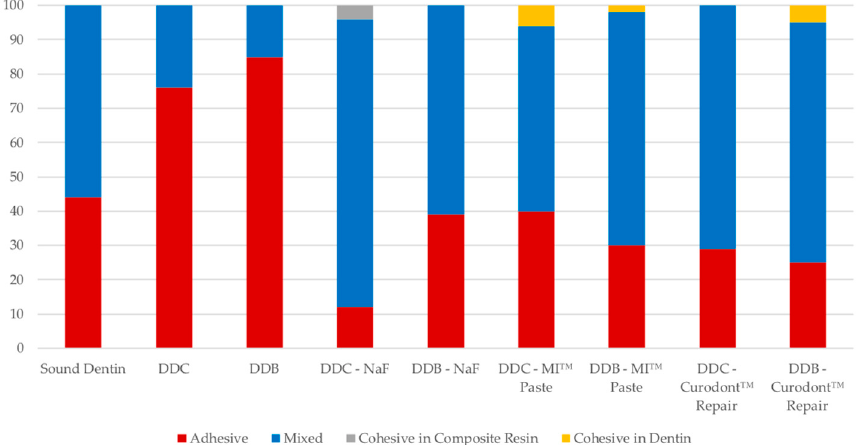
Figure Figure 3. Distribution of failure modes. DDC—Demineralized Dentin by chemical model; DDB— Demineralized Dentin by biological model; NaF—Sodium Floride; MI Paste™-CPP-ACP—Casein phospopeptide-amorphous calcium phosphate; Curodont™ Repair—P 11 -4—Peptide self-assembly.